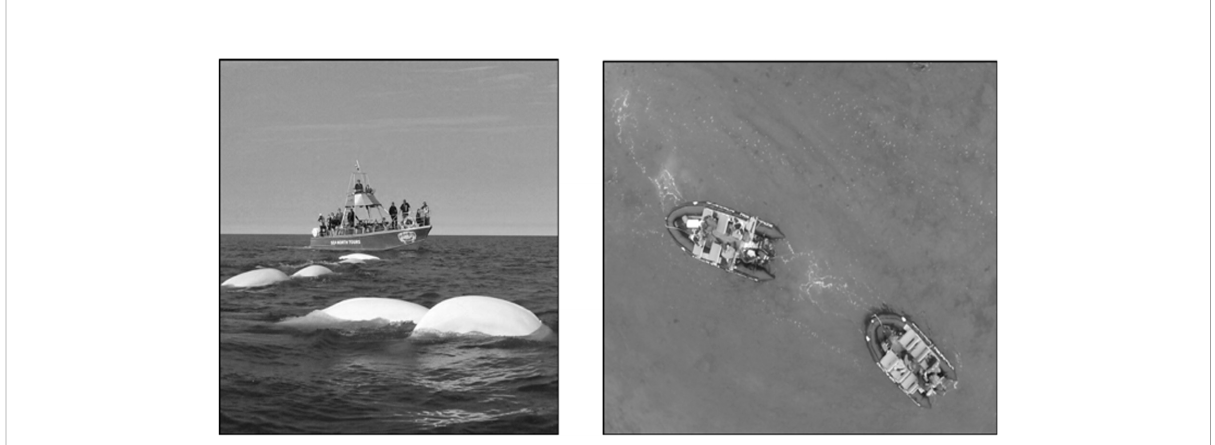
FIGURE 2 The Sea North II passenger vessel (L) and zodiacs (R) used to provide tourists with views of beluga whales in the Churchill estuary (Photo credits: L: Sea North; R: Oceans